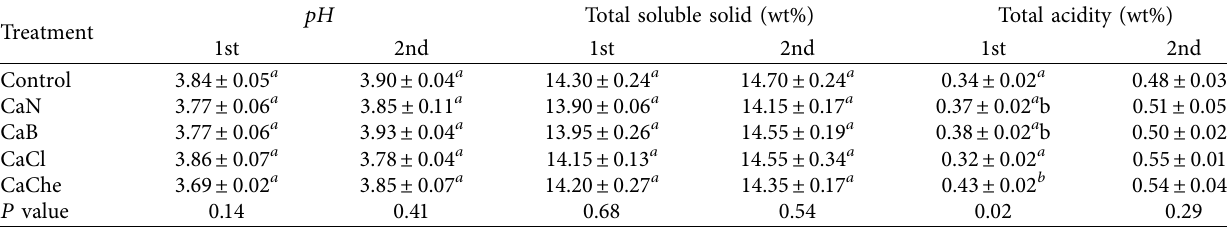
Table 4: Effect of calcium sprays on pH , TSS, and TA in fruit